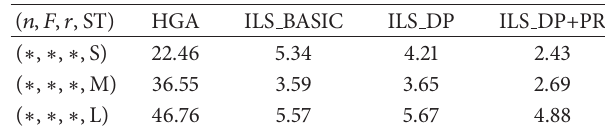
Table 8: Average RDIs (%) for instances grouped by setup time ranges